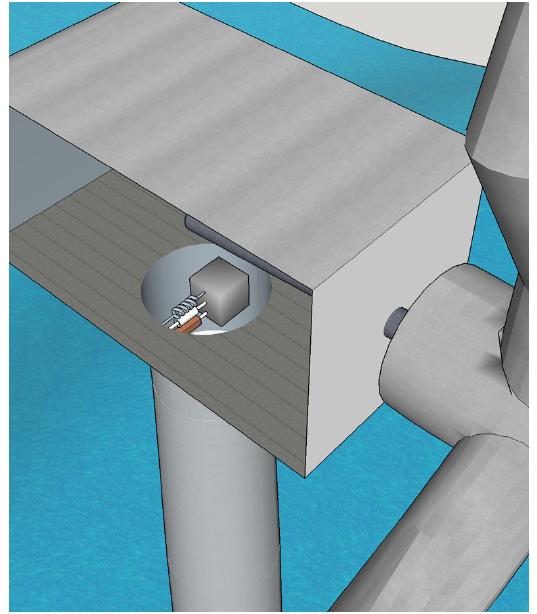
Figure 6. TMDI installed inside tower